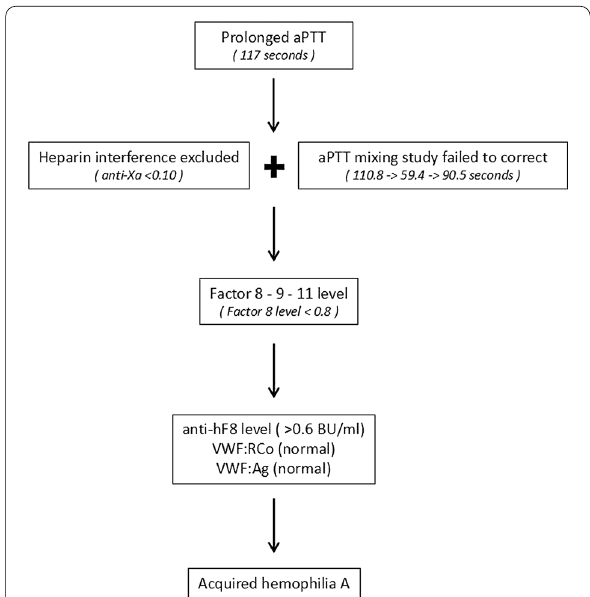
Table 1 Perioperative management for cardiac surgery in patients with acquired hemophilia A [4, 5]